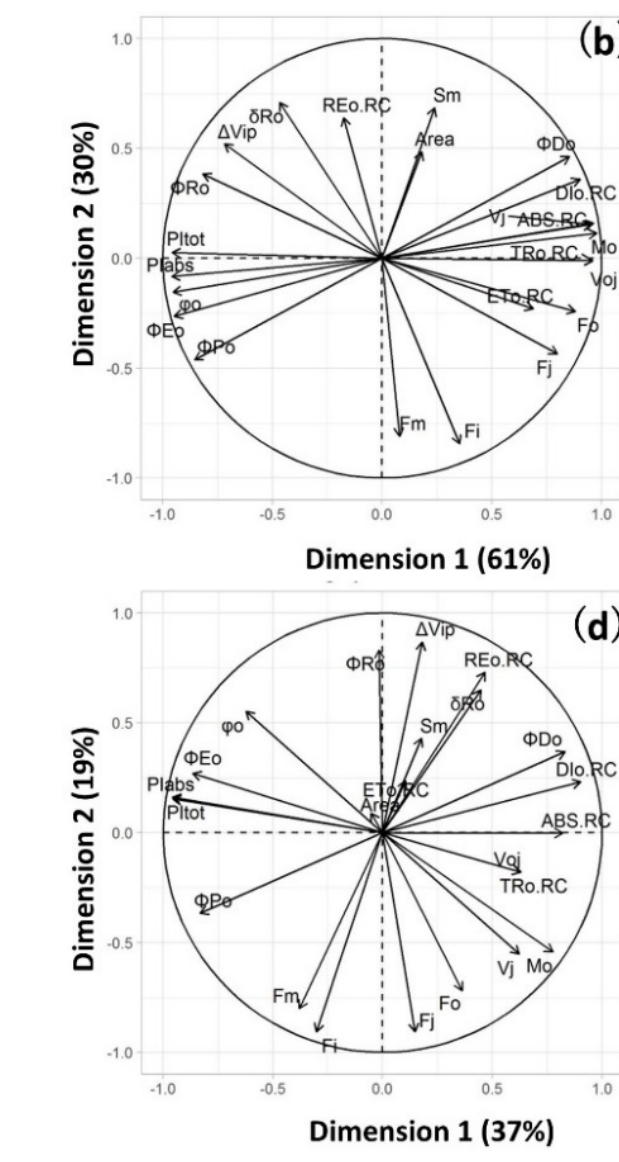
Figure 2. Biplots of principal component analyses of chlorophyll fluorescence OJIP kinetic parameters in wheat ( a ), sorghum ( b ), F. chinensis ( c ) and R. sinica ( d ) across all time points.